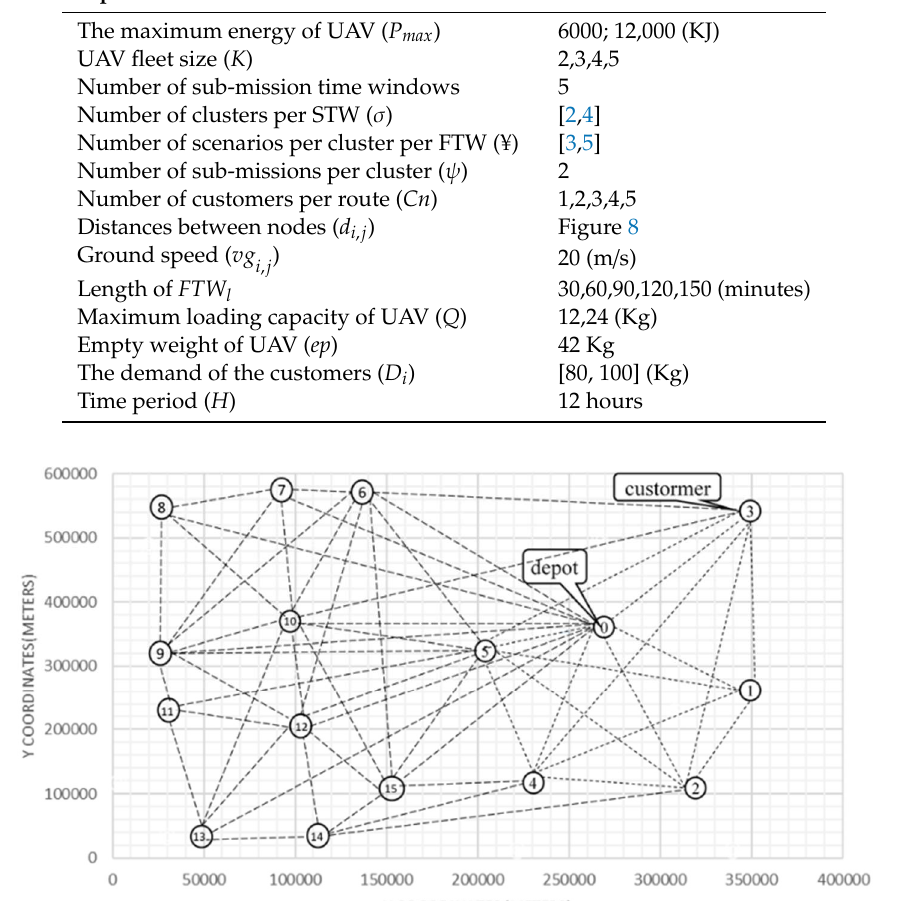
Figure 8. Map with customer locations and network.